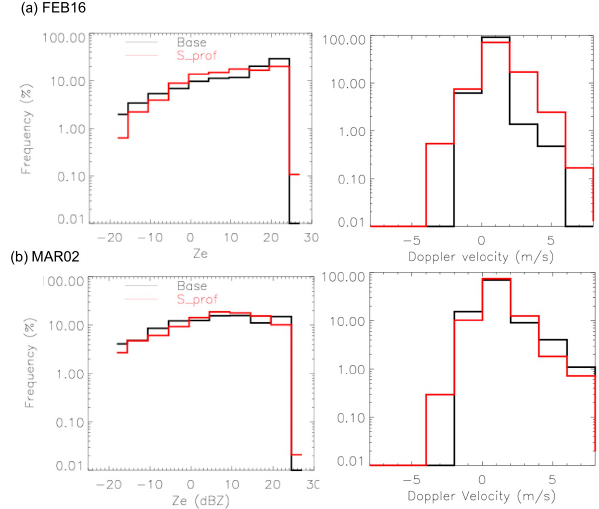
Fig. 7. Comparison of the modeled frequency distribution (black) of radar reflectivity and Doppler velocity from the radar simulator of the base run with the S-PROF measurements (red) for (a) FEB16 and (b) MAR02. The S-PROF (2875Mhz) is located at Sacramento.